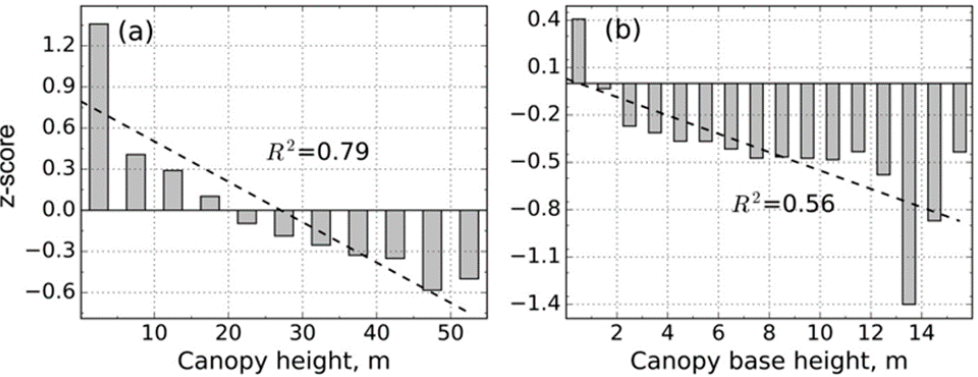
Figure 7. Relationship between z -score (significant differences) in modeled CBP between Model 1 and Model 3 (Canopy Base Height + Error) and ( a ) canopy height, and ( b ) canopy base height.